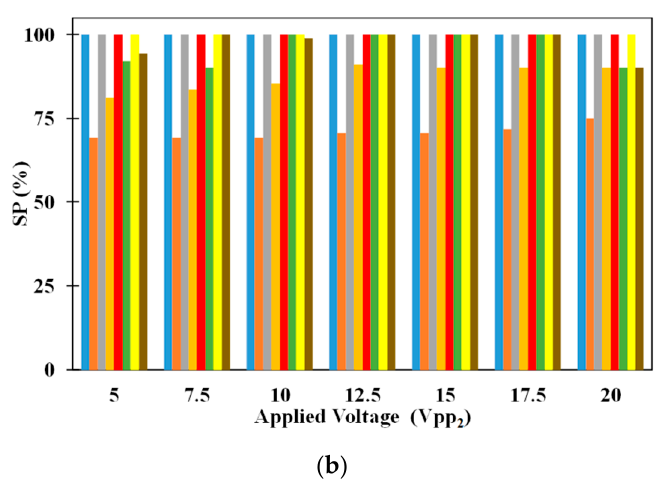
Figure 5. Influence of electrode dimensions on ( a ) SE and ( b ) SP for l = 40 μ m and d = 10 μ m ( ■ : 2.5 μ m, ■ 5 μ m), l = 80 μ m and d = 20 μ m ( ■ : 2.5 μ m, ■ 5 μ m), l = 120 μ m and d = 30 μ m ( ■ : 2.5 μ m, ■ 5 μ m), and l = 160 μ m and d = 40 μ m ( ■ : 2.5 μ m, ■ 5 μ m); n = 30, Q m = 200 μ L/h, W ch = 100 μ m, H ch = 100 μ m, V pp1 = 20 V pp , N = N cr,5 = 192.8 kHz.